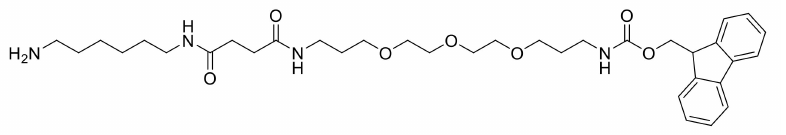
Figure 10. Chemical structure of 4 .